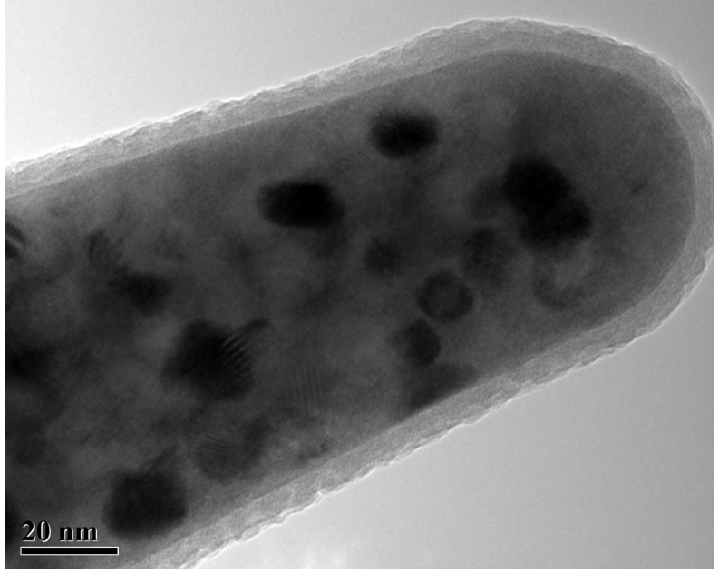
Figure 4. TEM morphology of APT sample.